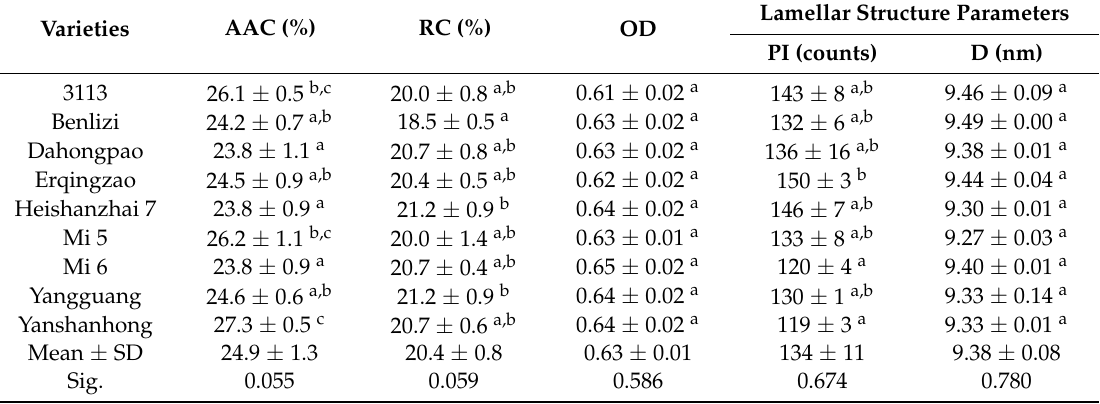
Table 3. Apparent amylose content, relative intensity, ordered degree, and lamellar structure parameters of starch.